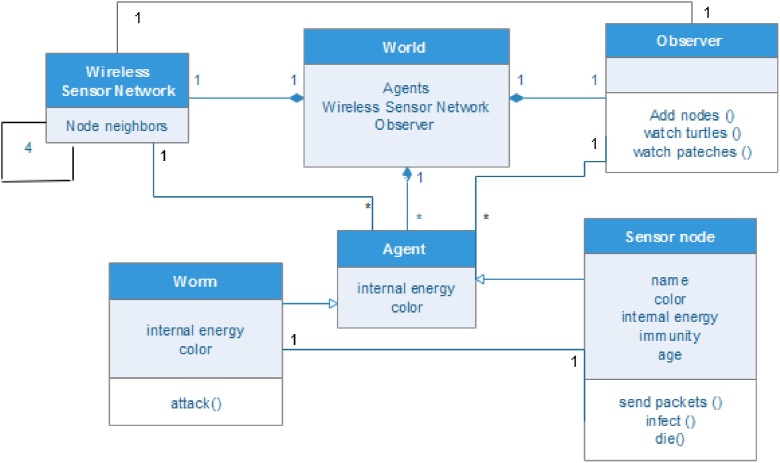
Class UML Diagram.